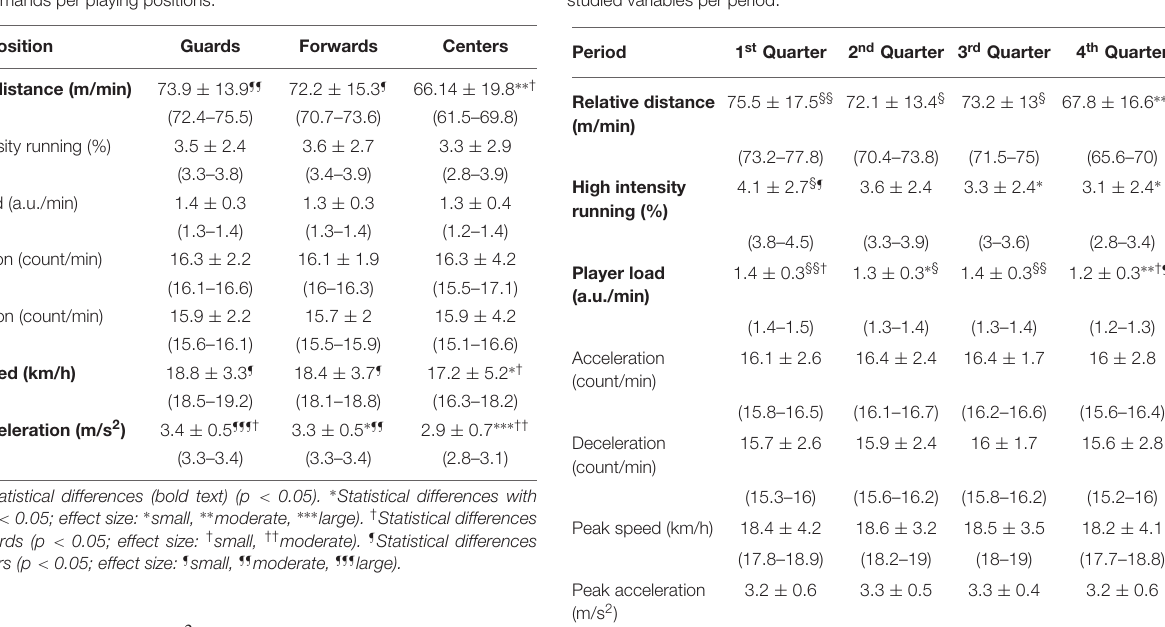
TABLE 3 | Means ± SDs, 95% Cis (in parentheses), one-way ANOVA and pair-wise comparisons with Cohen’s effect sizes (d) of basketball time-motion studied demands per playing positions.